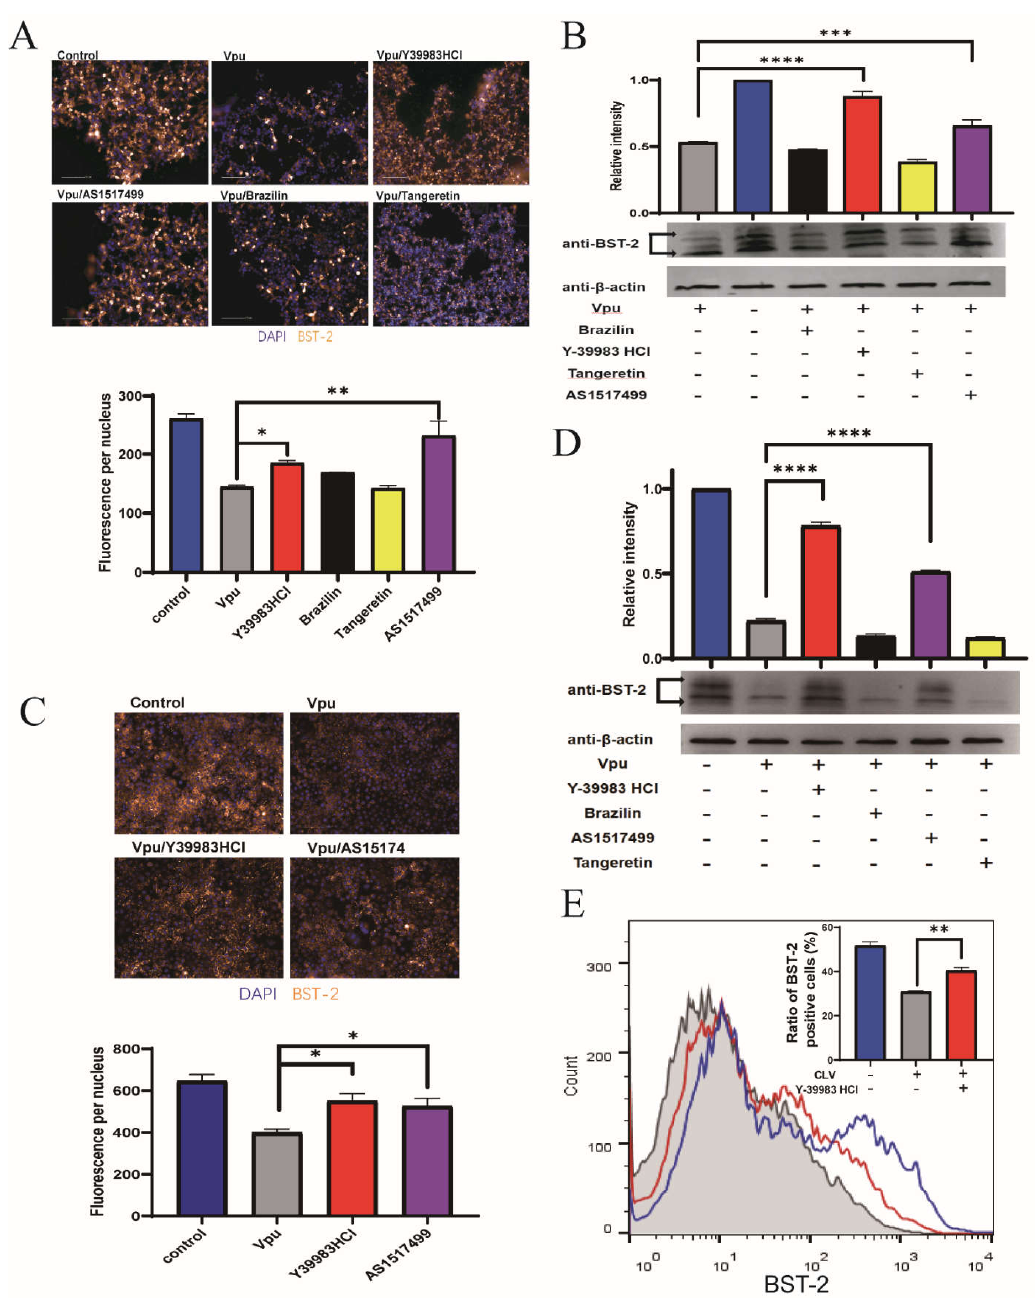
Figure 3. Compounds inhibited Vpu-mediated downregulation of BST-2. HEK293T cells were co-transfected with plasmids CLV (Vpu with C-terminal LgBiT) and NSB (BST-2 with N-terminal SmBiT), and treated with Y-39983 HCl, brazilin, tangeretin, or AS1517499 (10 µ mol/L) for 36 h. Total cellular expression of BST-2 was measured using a high-content imaging system ( A ) and Western blotting ( B ). ( C ) HeLa cells were transfected with CLV vector and treated with Y-39983 HCl, brazilin, tangeretin, or AS1517499 (10 µ mol/L) for 36 h. Total cellular expression of BST-2 was measured by high-content imaging analysis and Western blotting ( D ). ( E ) HEK293T cells were co-transfected with plasmids CLV and NSB, and treated with Y-39983 HCl, the cell-surface expression of BST-2 was detected by flow cytometry. *, p < 0.05; **, p < 0.01; ***, p < 0.001; ****, p < 0.0001 vs. Vpu group. Values presented are the mean ± SD of three replicates. All experiments were performed